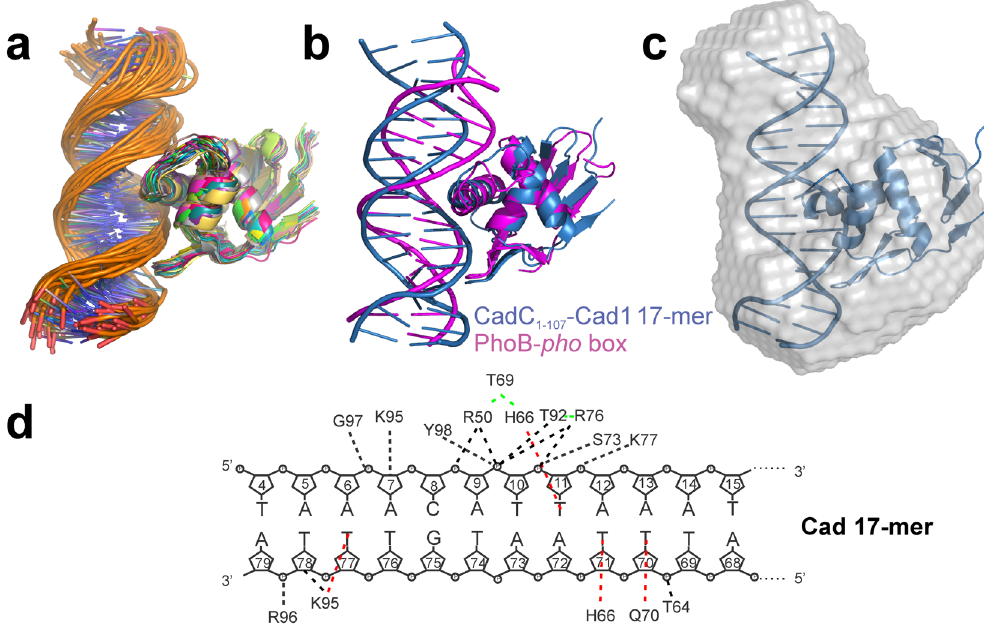
Figure 6. HADDOCK model of the CadC 1-107 structure with the Cad1 17-mer DNA. ( a ) Overlay of all 26 ensemble structures within the respective cluster from a HADDOCK modelling of CadC 1-107 with Cad1 17- mer DNA (Supplementary Table S3). ( b ) Alignment of the lowest-energy model for the CadC 1-107 /Cad1 DNA complex from ( a ) with the structure of the PhoB- pho box DNA complex (PDB: 1gxp 16 ) (see Fig. 1d). DNAs are coloured according to proteins. ( c ) Superposition of a SAXS-derived ab initio shape model of a 1:1 complex of CadC 1-107 with 17-mer Cad1 DNA (grey, semi-transparent) with the lowest-energy structure from the cluster in ( a ) shown as blue cartoon. ( d ) Contacts of CadC 1-107 in complex with Cad1 17-mer DNA. Red lines indicate sequence-specific interactions of protein side chains with DNA bases. Black lines are contacts to the DNA backbone, i.e. the phosphate or the sugar groups. Green lines show relevant, sequence-specific protein-protein